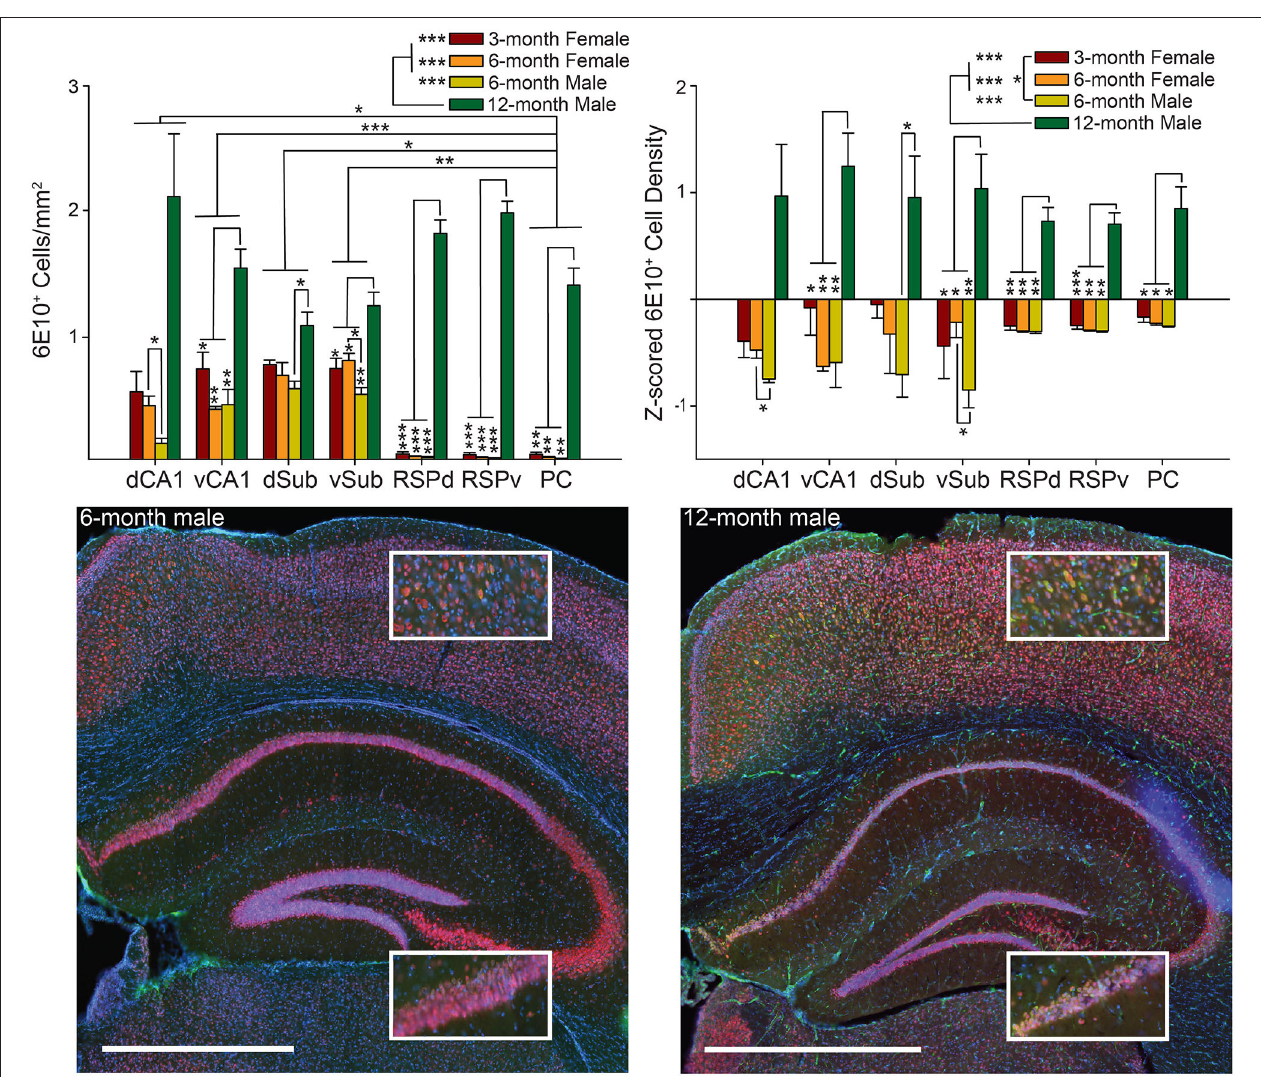
FIGURE 2 | Male 6-month 3xTg-AD mice have a lower 6E10 positive cell density than 6-month females, while 12-month males have the highest 6E10 positive cell density. Top. 6E10 positive cell density ( left ) and Z -scored density ( right ) for each of the seven brain regions and four groups of mice. Bottom. Representative images showing 6E10 staining (green) in Dorsal Retrosplenial Cortex (RSPd; Top Insets) and Dorsal CA1 (dCA1; Bottom Insets) for 6-month ( left ) and 12-month ( right ) male 3xTg-AD mice. Sections were also stained with NeuN (red) and DAPI (blue). Ventral CA1 (vCA1), Dorsal Subiculum (dSub), Ventral Subiculum (vSub), Ventral Retrosplenial Cortex (RSPv), and Parietal Cortex (PC). * p < 0.05, ** p < 0.01, *** p < 0.001. Scale bar =